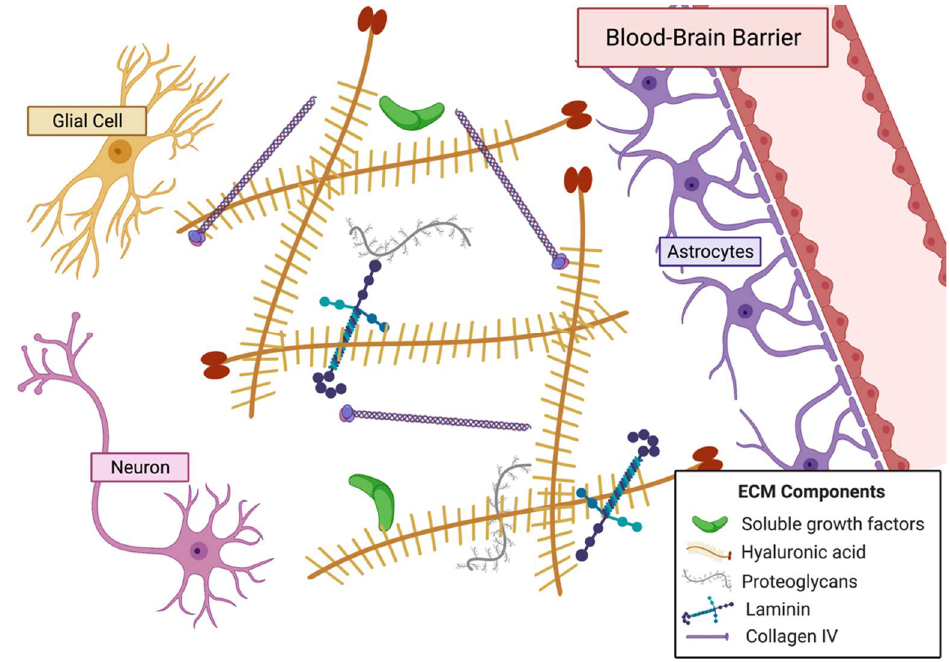
Figure 5. Extracellular matrix (ECM) of the brain. The ECM of the brain has a unique composition, including hyaluronic acid, collagen IV, and other ECM components along with glial cells, neurons, and astrocytes. The blood-brain barrier (BBB) is a neurovascular unit composed of vascular endothelial cells with surface charge modifications, tight junction proteins, pericytes, astrocytes, and other components. The BBB is selectively permeable and can block solutes in the systemic blood from entering the environment of the central nervous system (Created with BioRender.com, accessed on 14 July 2022).